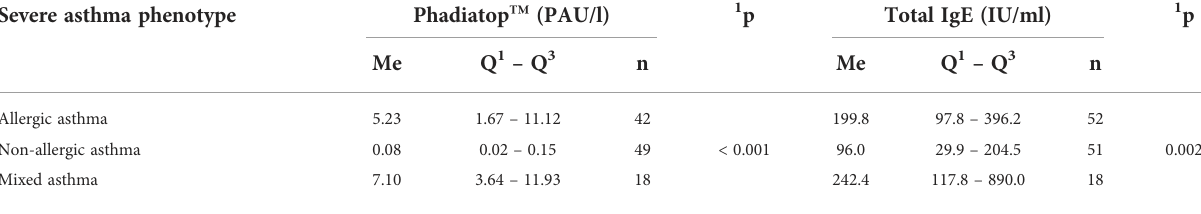
TABLE 2 Speci fi c IgE measured by Phadiatop ™ and total IgE levels in patients with different phenotypes of severe asthma. Severe asthma